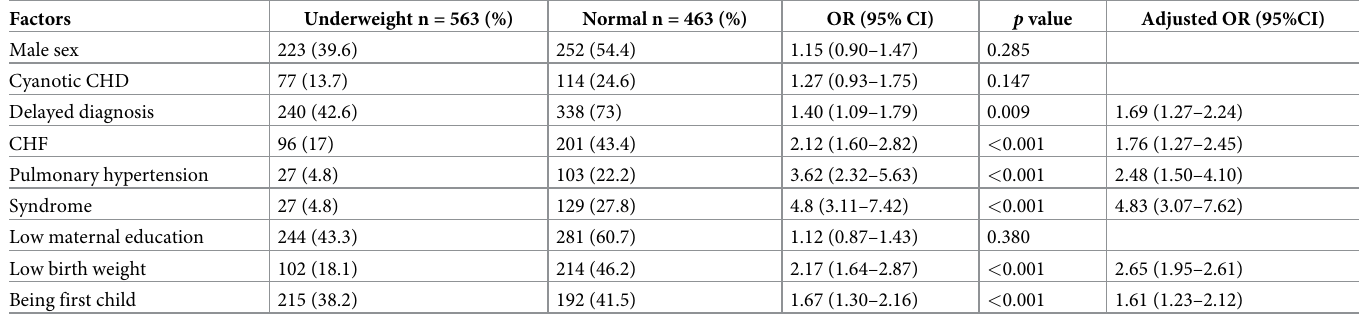
Table 2. Factors associated with